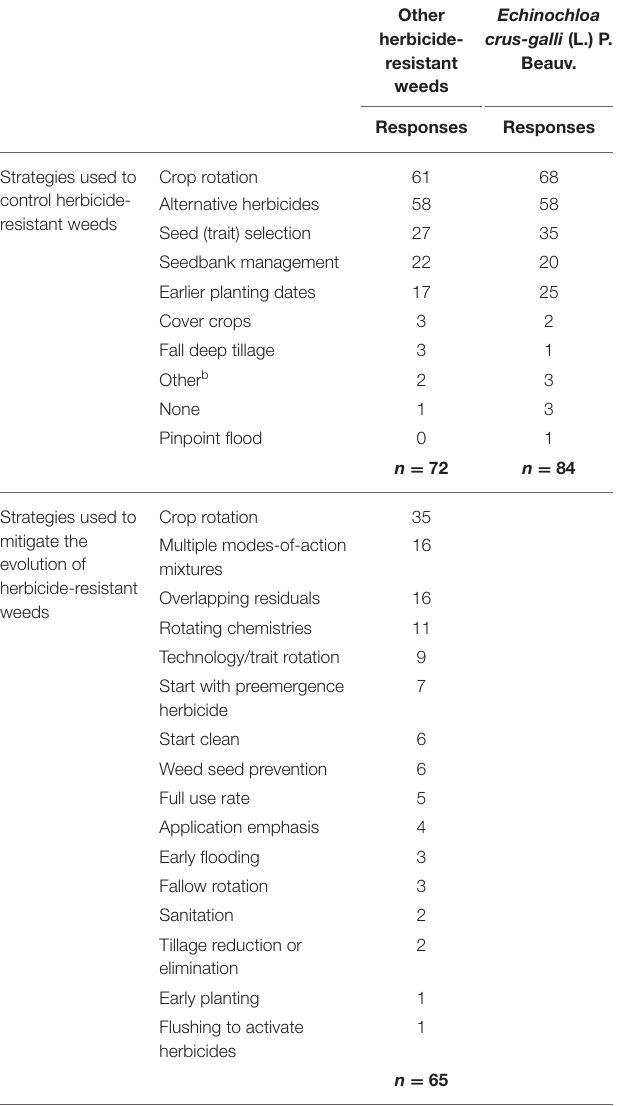
TABLE 5 | Strategies reported from respondents being used to control herbicide-resistant weeds and Echinochloa crus-galli (L.) P. Beauv. and to mitigate the evolution of herbicide-resistant weeds a .